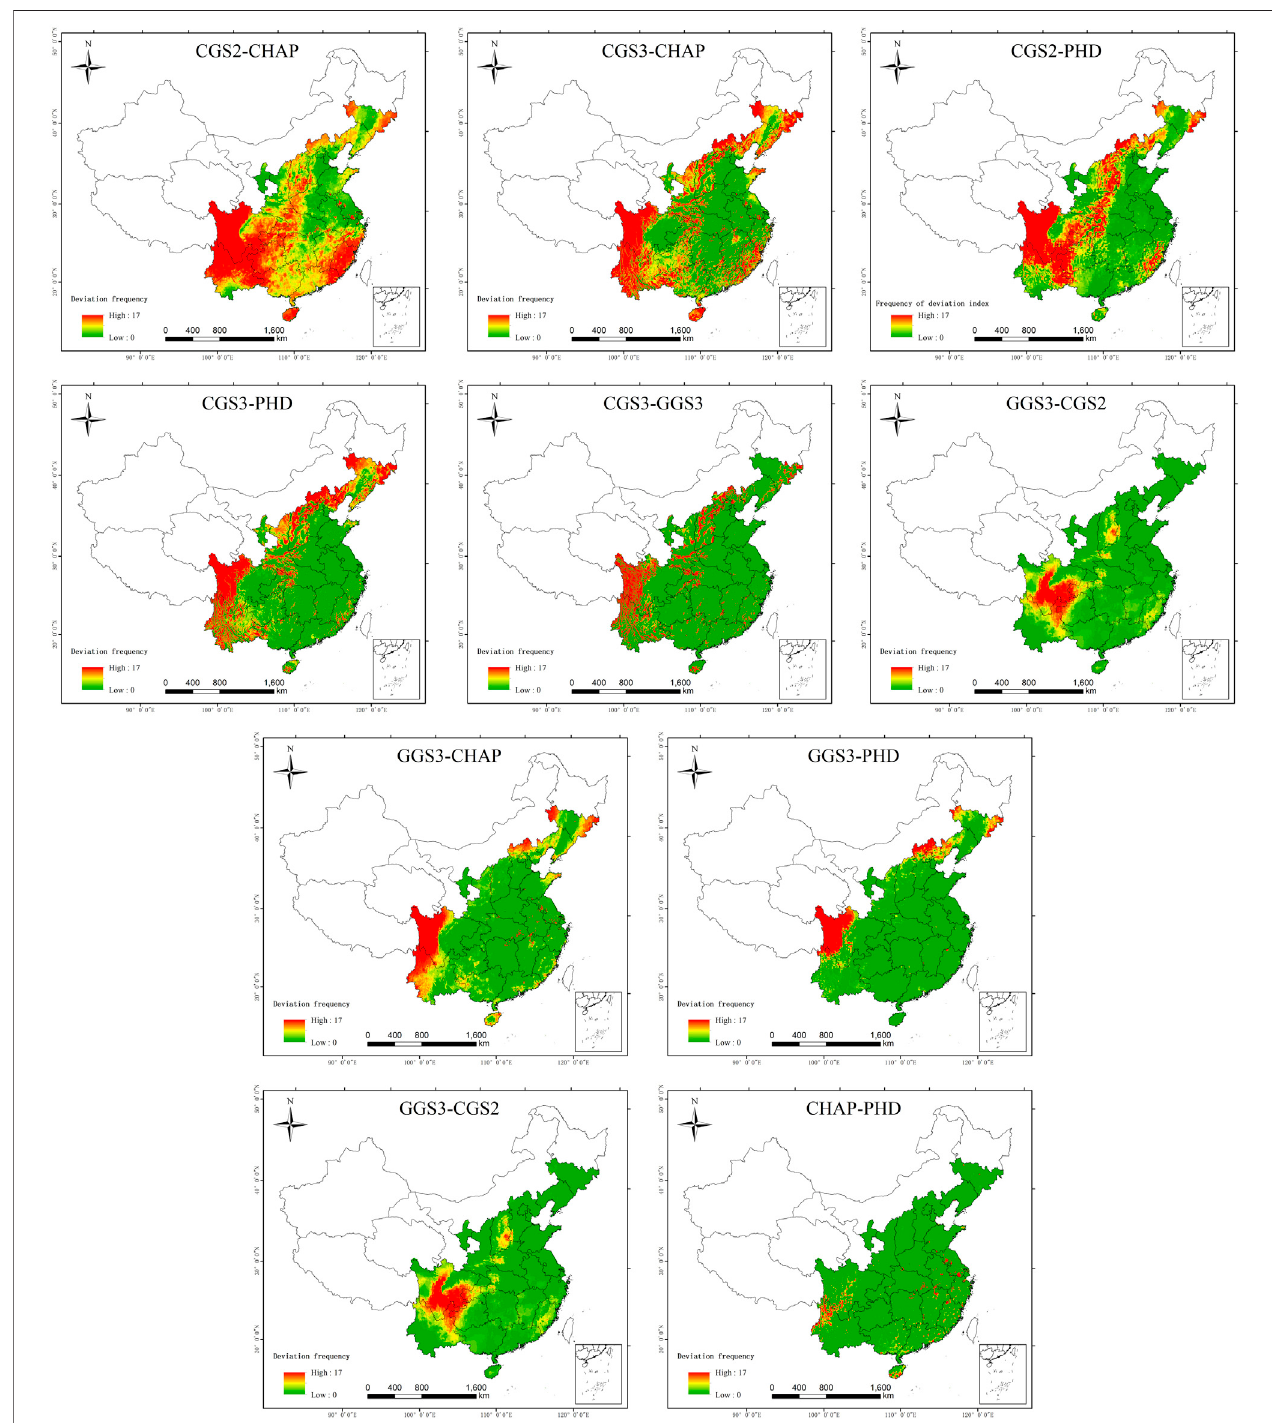
FIGURE 7 | Spatial distribution of deviation frequency in PM 2.5 concentration between any two PM 2.5 datasets.